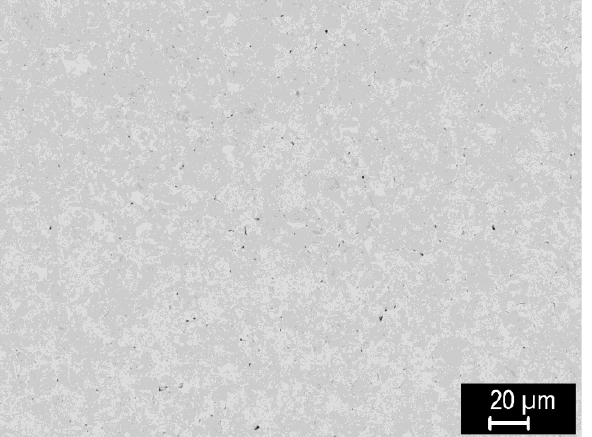
Figure 3. Microstructure of tungsten compact sintered at 2000 °C from the −2 0 μ m powder.